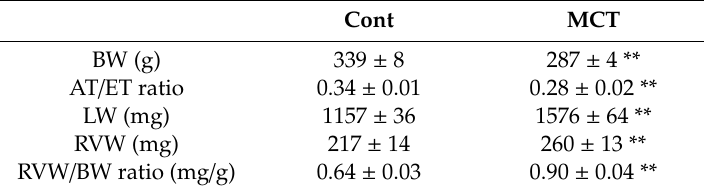
Table 1. Body weight (BW), acceleration time (AT) / ejection time (ET) ratio, lung weight (LW) and right ventricular (RV) weight (RVW) of rats used to measure expression levels of canstatin in plasma and